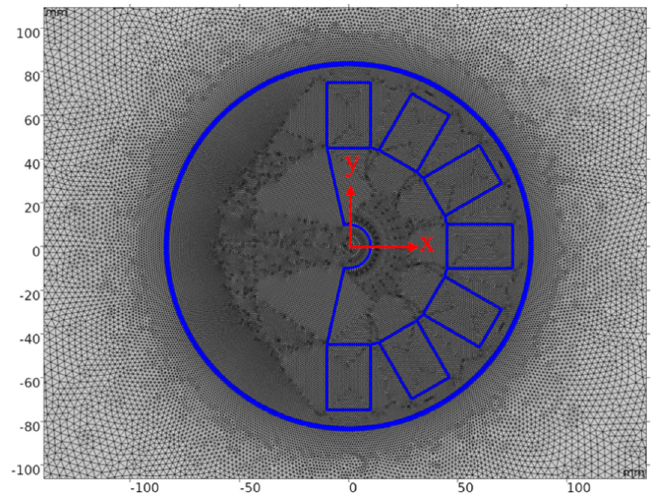
Figure 2. 2D structure and mesh generation of the main body of ADMS.